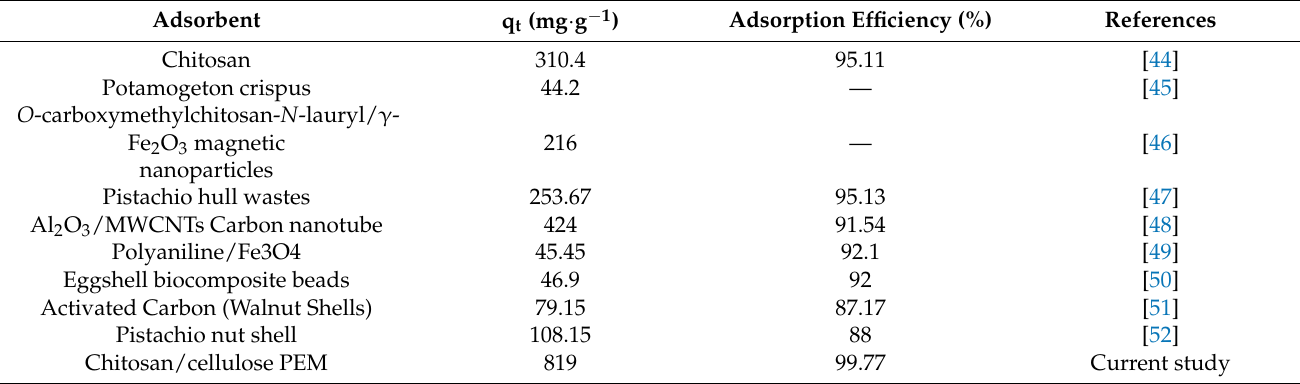
Table 2. Comparison of maximum adsorption capacities (mg · g − 1 ) of Reactive Red 198 dye from the literature by other adsorbents.